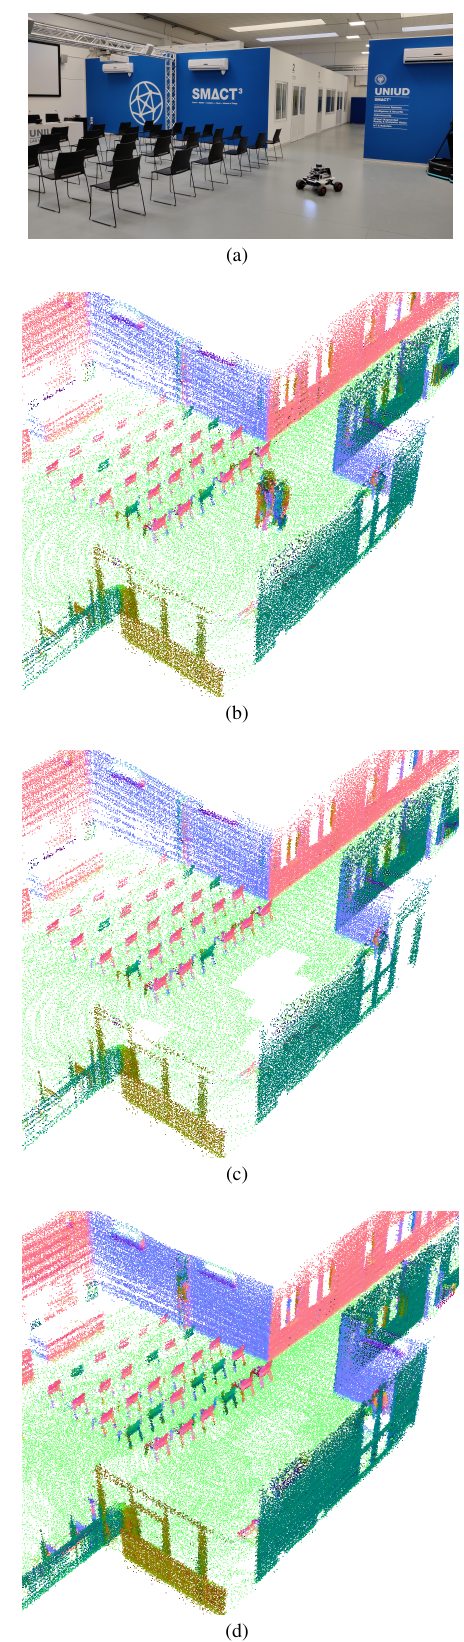
Figure 7. Test case (1): scanned environment (a); people detected (b); point cloud with data gaps (c); final point cloud (d).